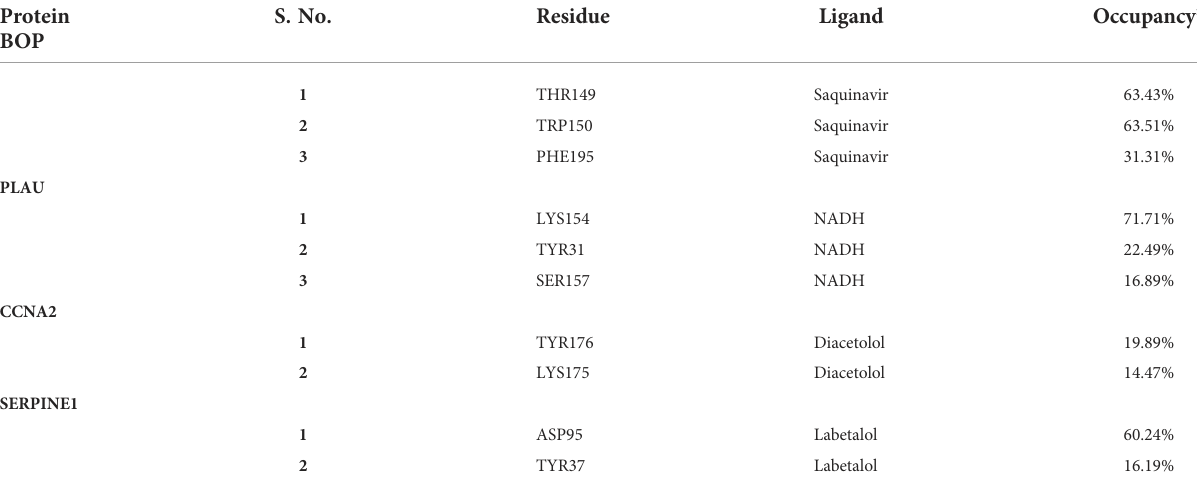
TABLE 1 Hydrogen bond analysis between the ligand and the protein. Protein S.